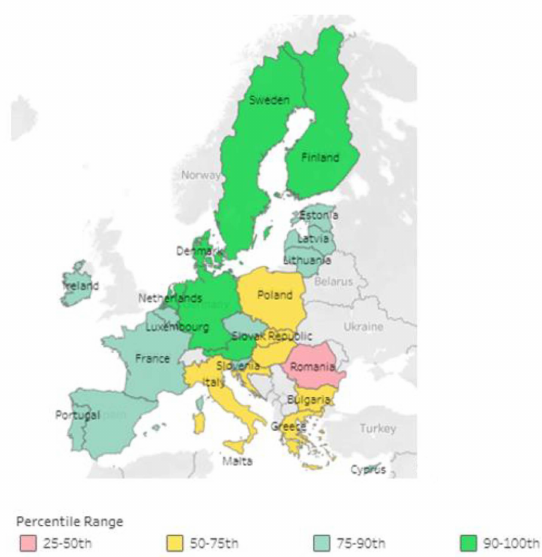
Figure 1. Evaluation of governance effectiveness in EU member states according to the WGI database, 2019. Source: Worldwide Governance Indicators—Government Effectiveness